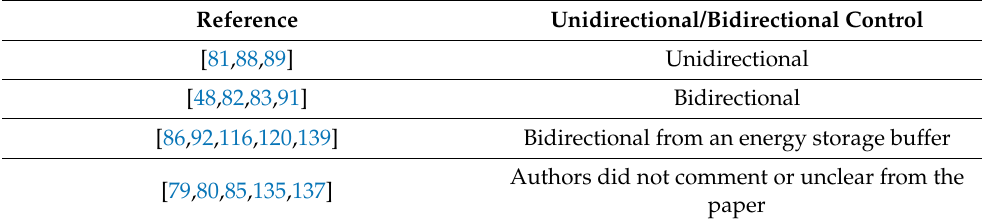
Table 4. Unidirectional/bidirectional POD through the active power control loop.